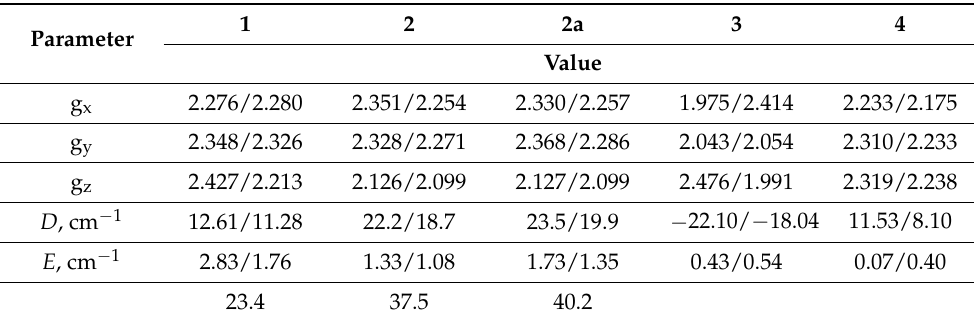
Table 6. Calculated (CASSCF and CASSCF + NEVPT2 level of theory) parameters of the effective spin Hamiltonian ( D - and g -tensors) for complexes 1 – 4